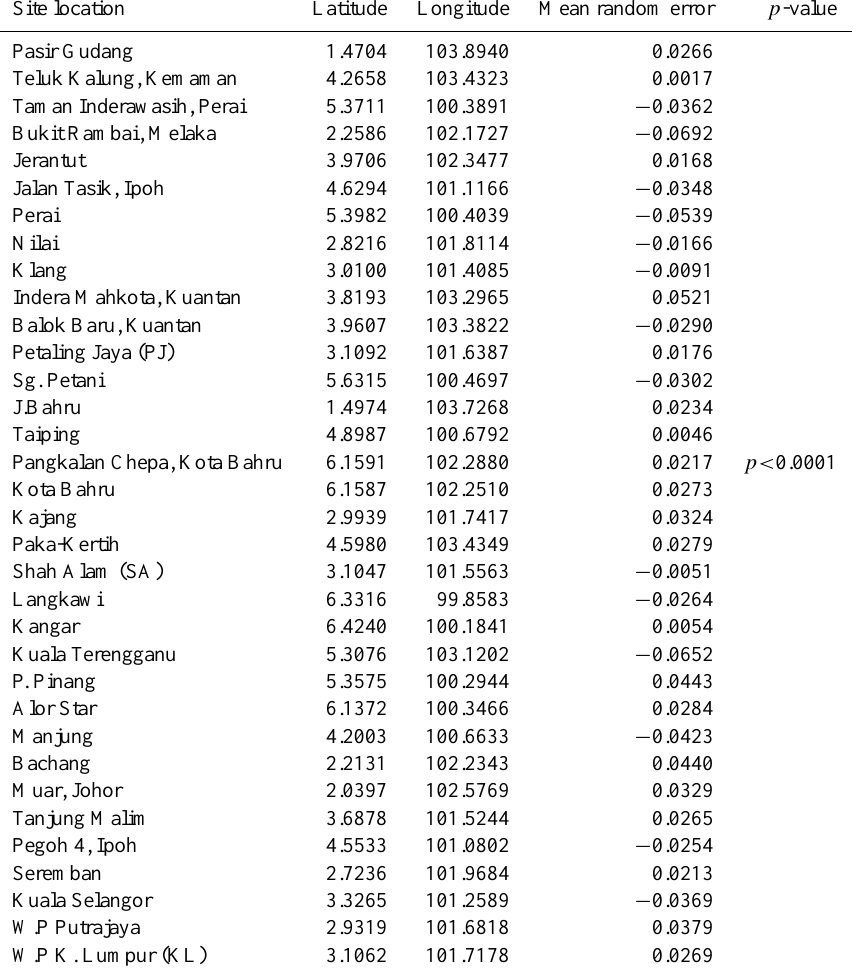
Table 2. Estimation of long-term (2001–2006) monthly mean random error (AOD) for 34 monitoring